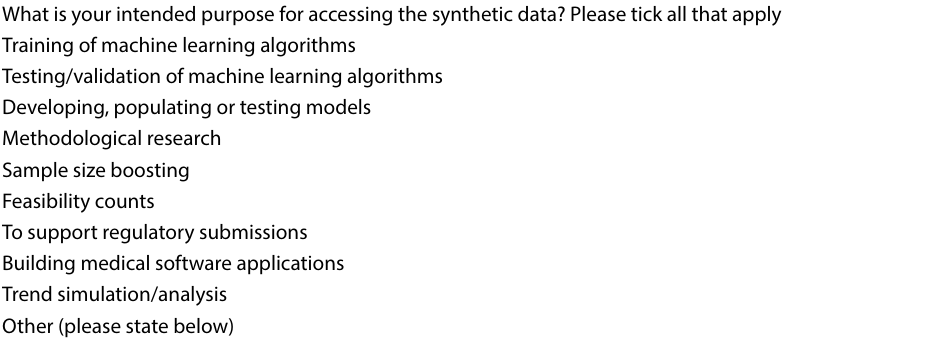
Table adapted from cprd.com 2021 Synthetic data